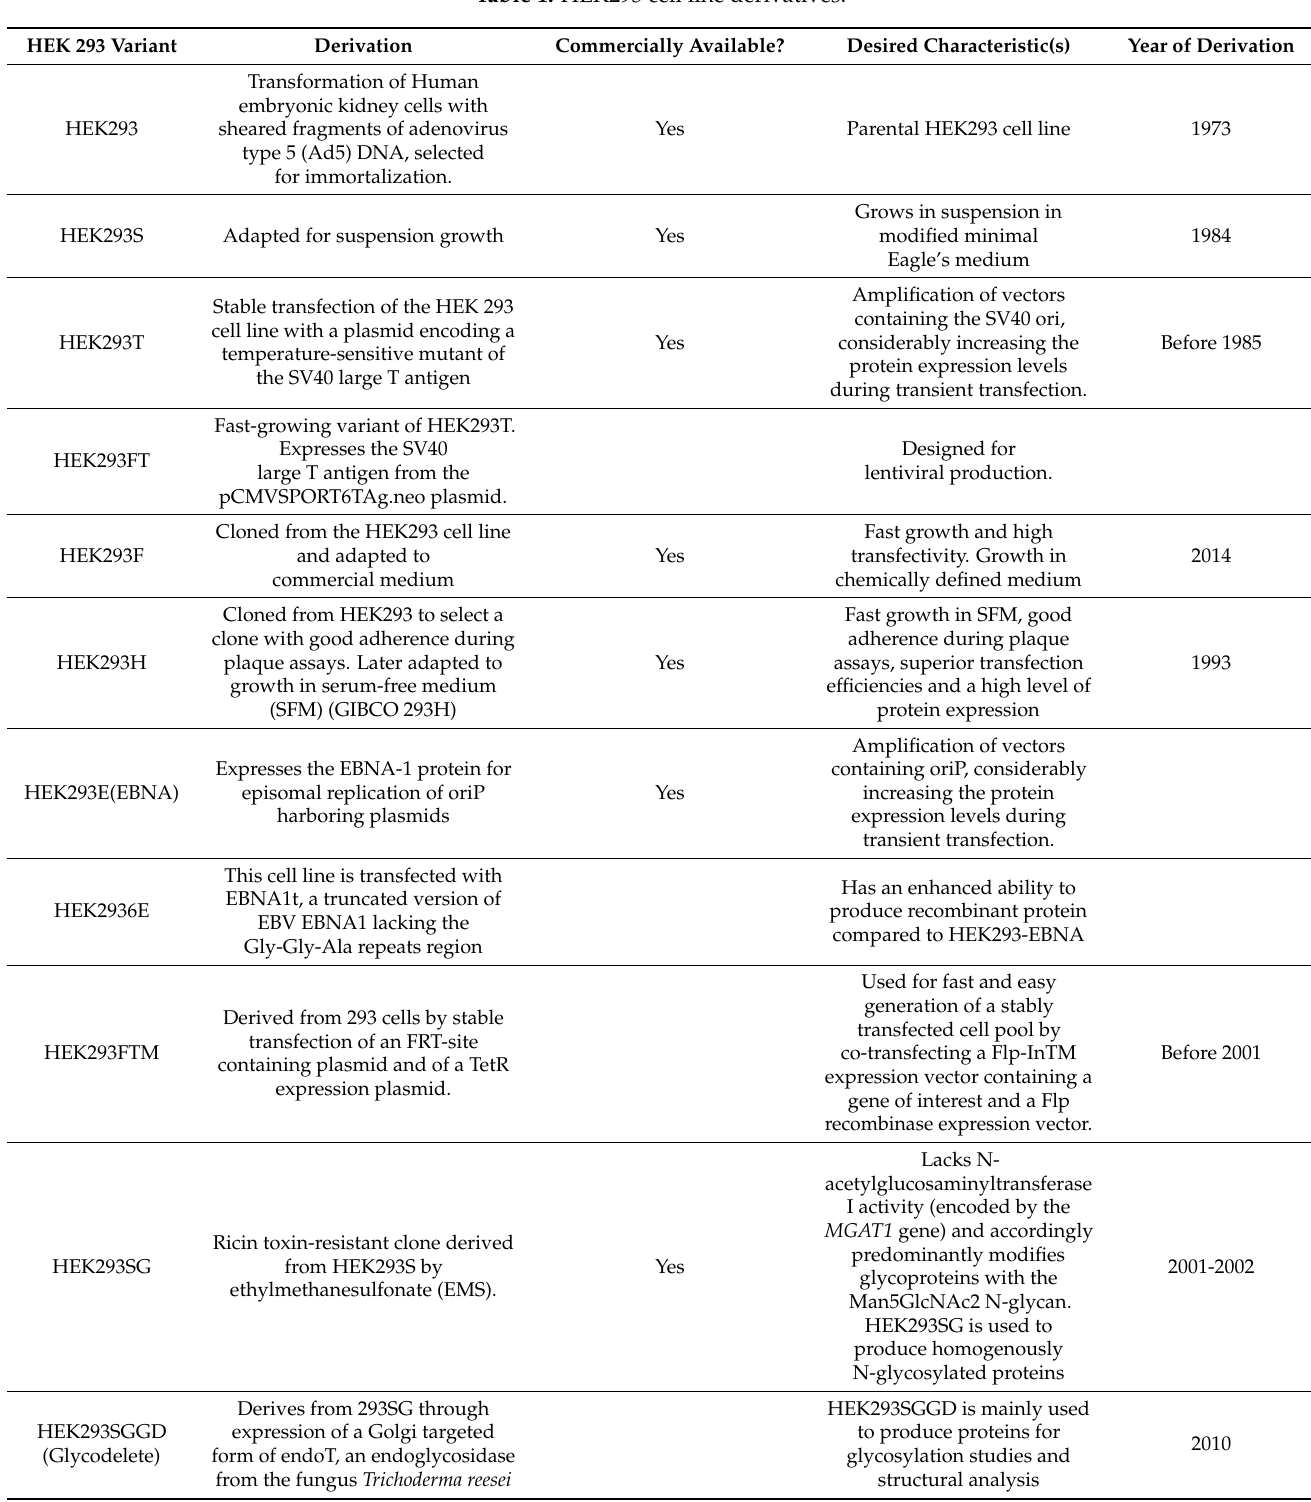
Table 1. HEK293 cell line